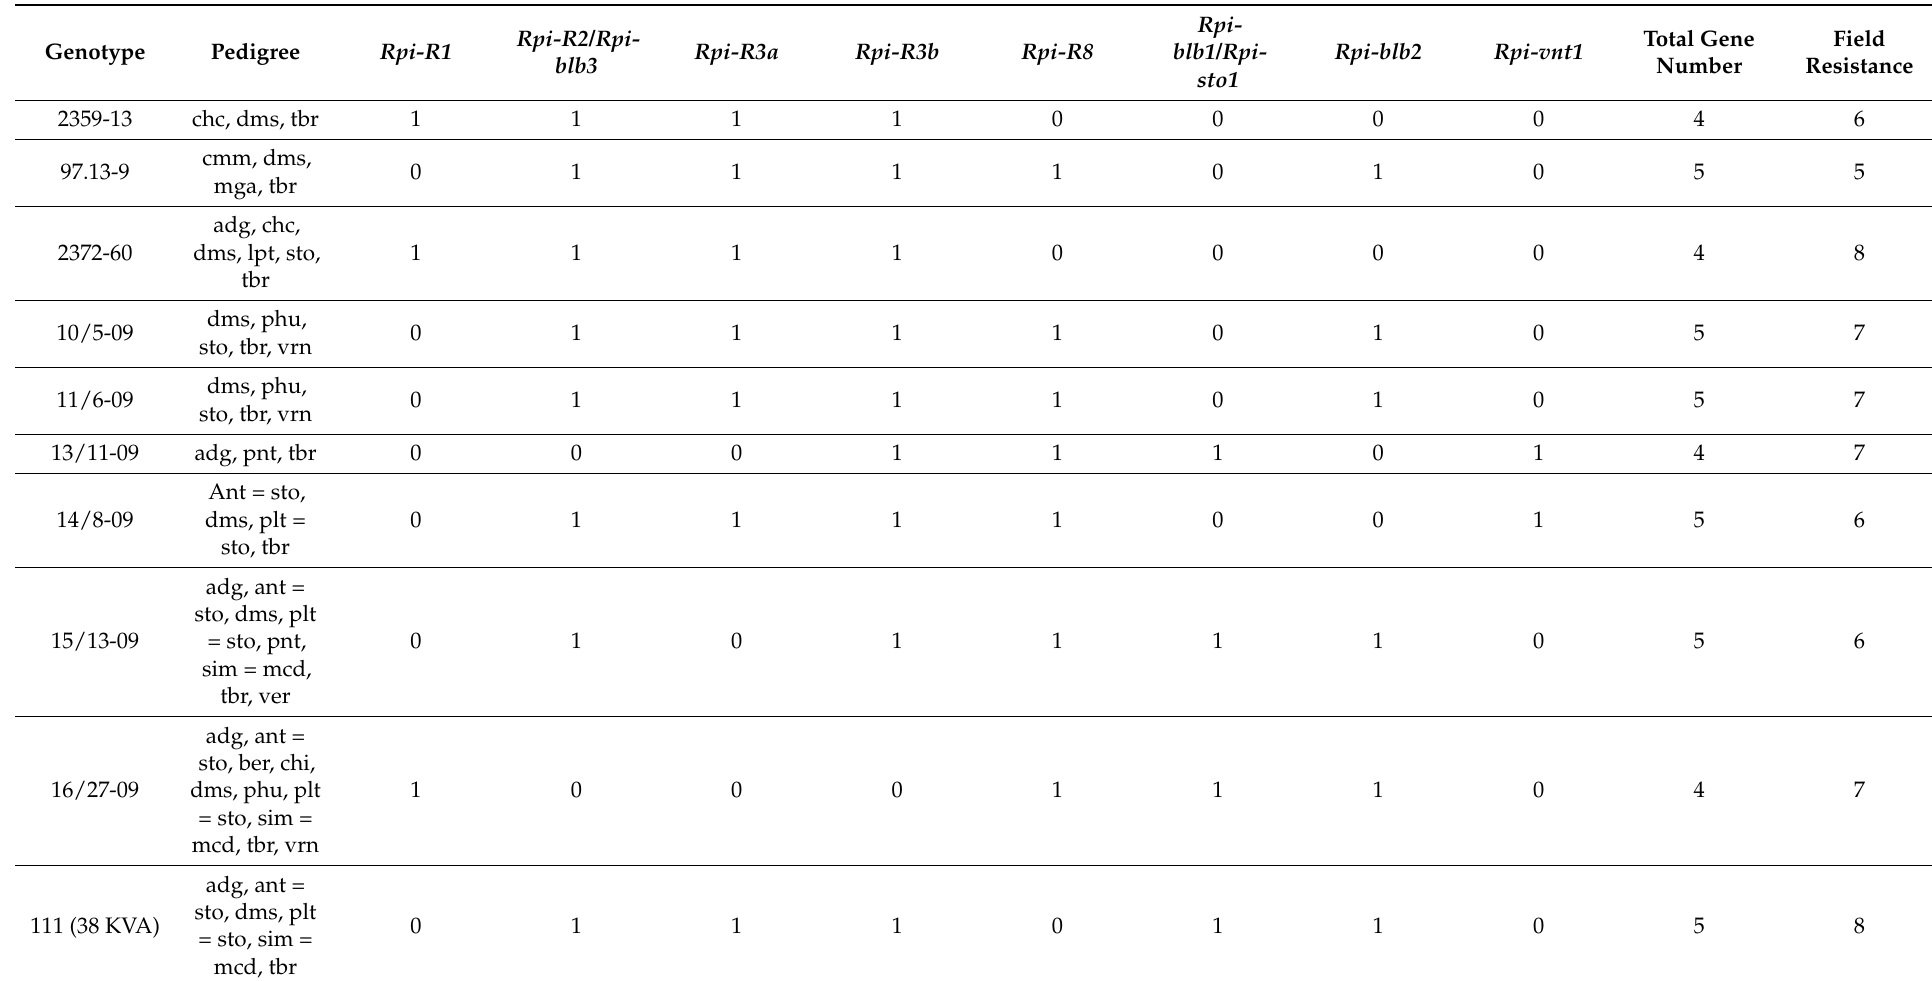
Table 5. Potato hybrids with 4+ Rpi